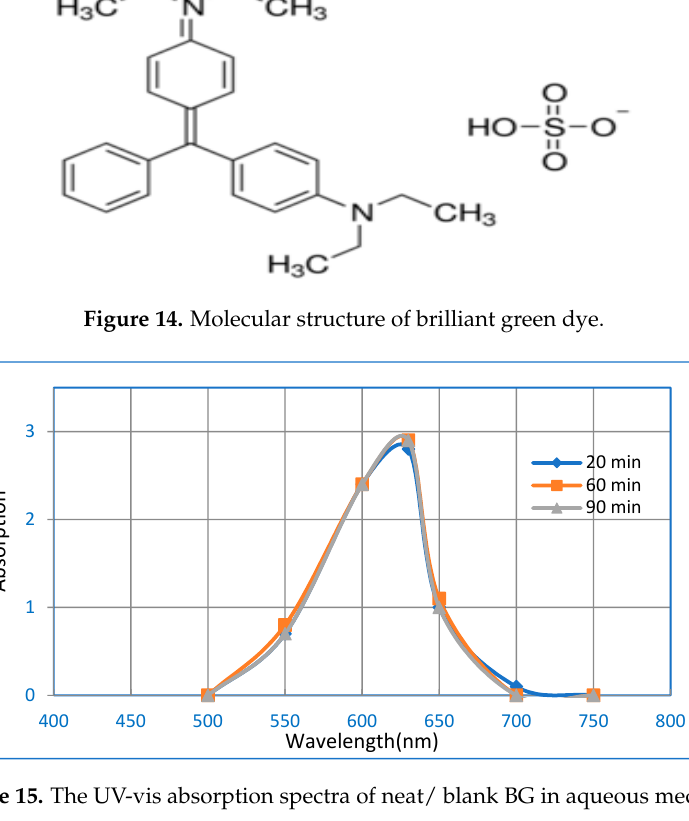
Figure 15. The UV-vis absorption spectra of neat/ blank BG in aqueous medium.